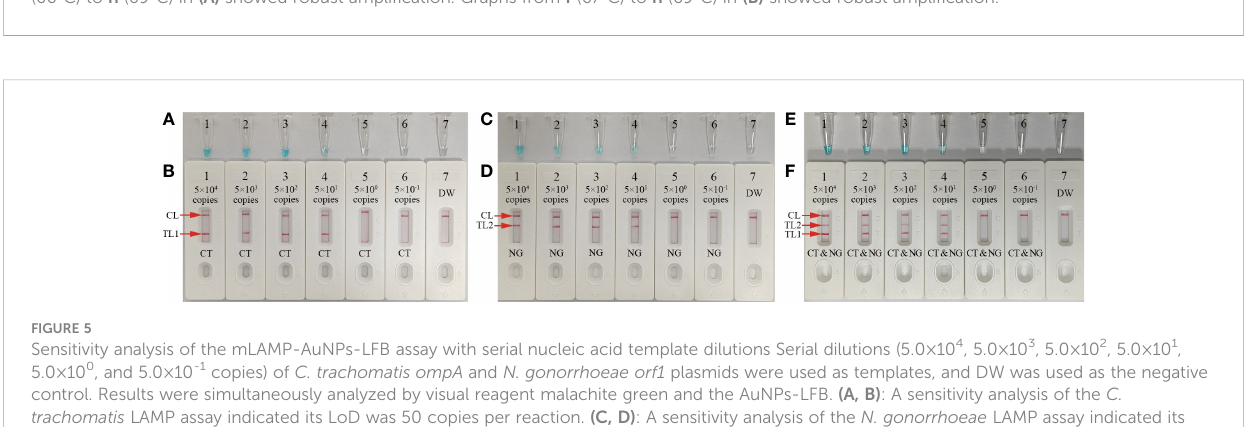
FIGURE 4 Temperature optimization for the ( C ) trachomatis and N. gonorrhoeae LAMP ampli fi cation LAMP ampli fi cations for (A) C . trachomatis and (B) N. gonorrhoeae were monitored using real-time turbidity, and their corresponding amplicon curves are shown as graphs. A turbidity >0.1 indicated a positive result. Eight kinetic graphs were obtained at different temperatures (62°C – 69°C in 1°C increments) with 1×10 4 target gene copies. Graphs e (66°C) to h (69°C) in (A) showed robust ampli fi cation. Graphs from f (67°C) to h (69°C) in (B) showed robust ampli fi